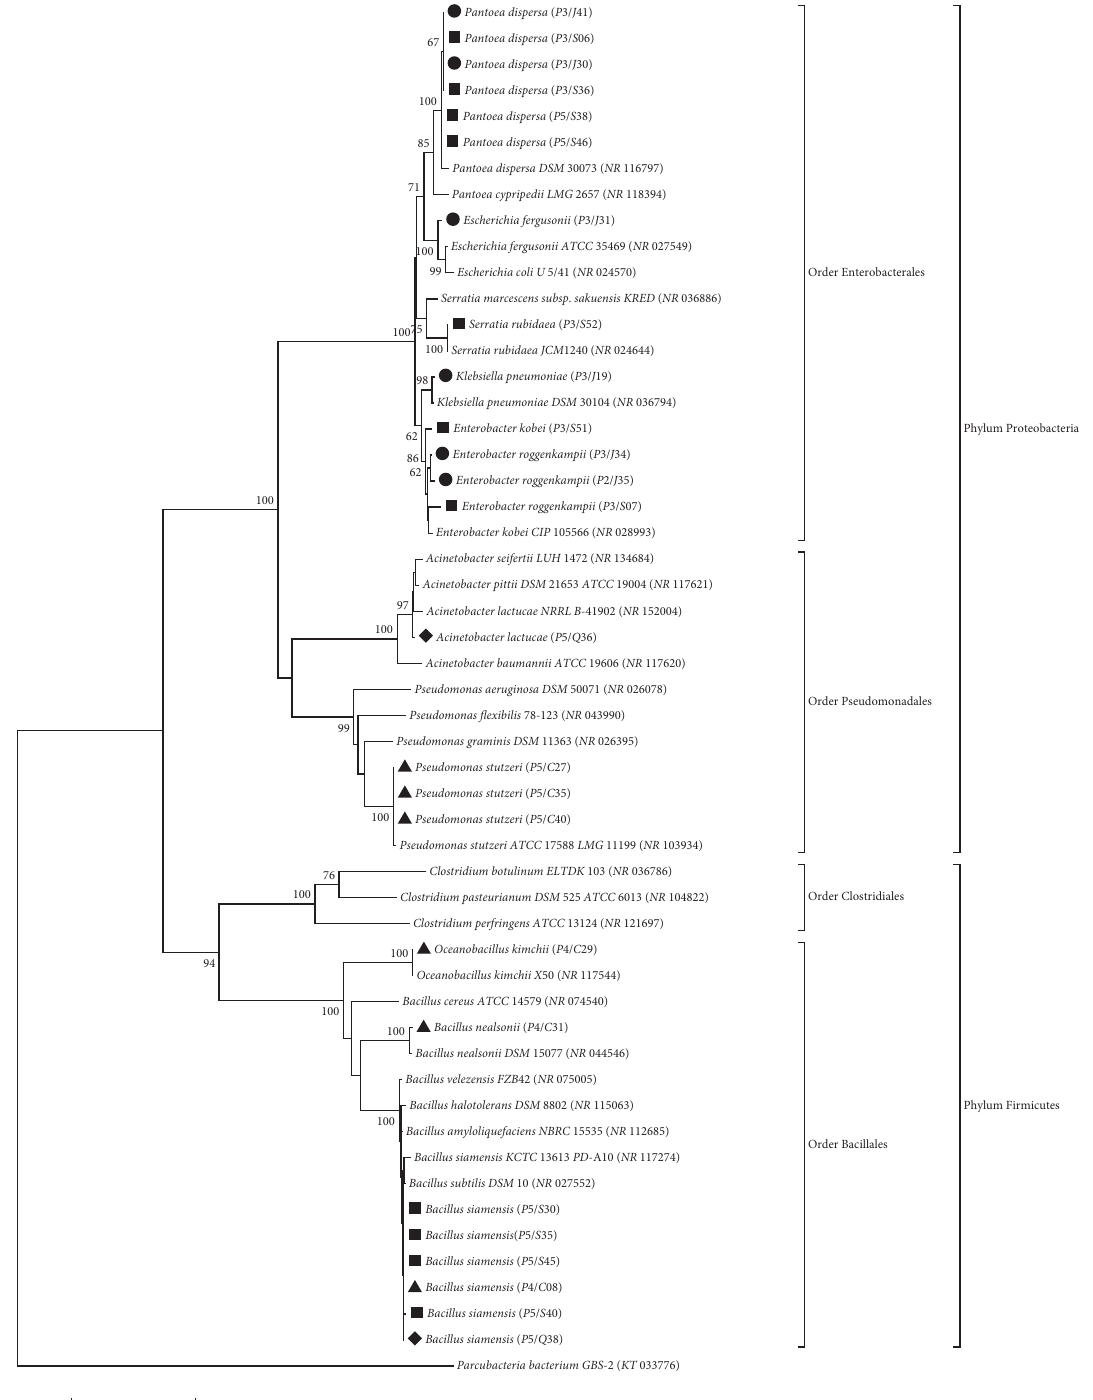
Figure 4: Phylogenetic tree of bacteria isolated from king coconut water processing facilities based on their 16S rRNA gene sequences. The strains isolated in this study are given in bold italics with isolation point and isolate ID. Each symbol denoted the following: ● Facility I (JA), ■ Facility II (SM), ▲ Facility III (CW), and ◆ quality-defected samples, respectively. The tree was constructed using the neighbor-joining method with MEGA 7. The percentages of bootstrap values for 1000 replicates are indicated at the branching point. The scale bar indicates changes per